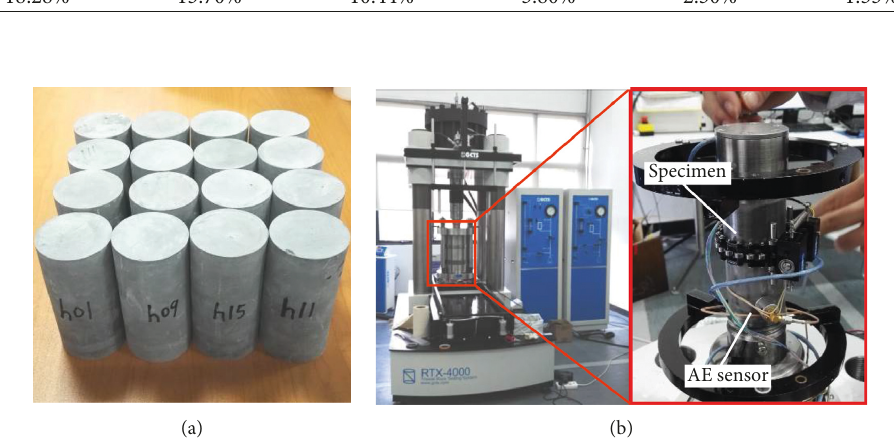
Figure 2: (a) Argillaceous limestone specimens and (b) RTX-4000 GCTS rock mechanics test